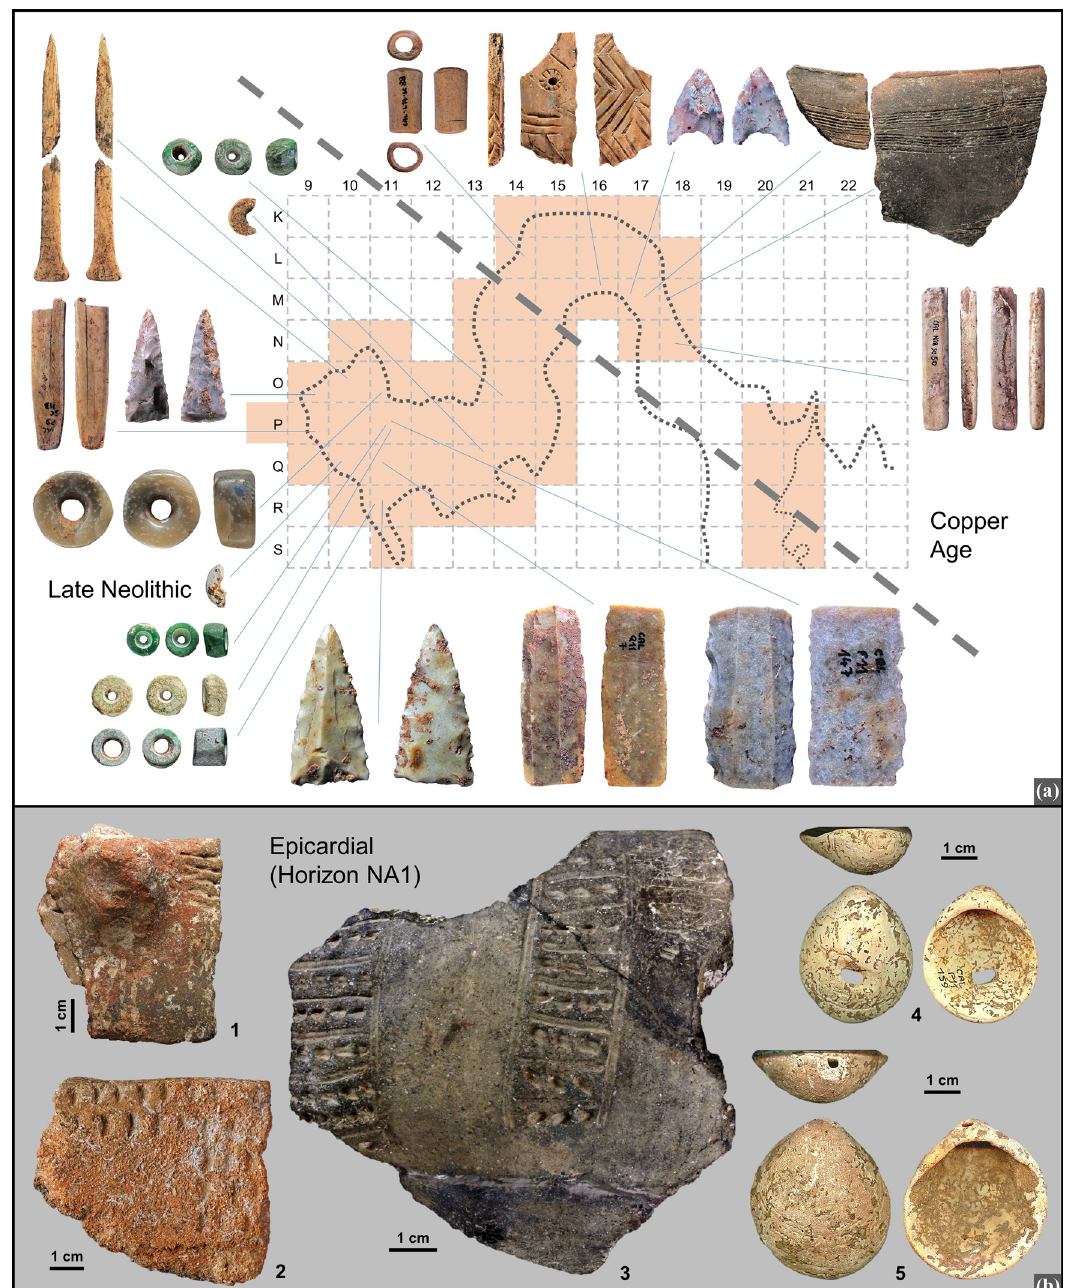
Figure 6: Gruta do Caldeirão. The post - Cardial Neolithic contexts. ( a ) Distribution of Late Neolithic and Copper Age diagnostics ( not to scale ) ; note the preservation of spatial structure despite the signi fi cant post - depositional disturbance ( Late Neolithic fi nds in the Back Chamber, Copper Age ones between Corridor and Entrance ) . ( b ) Impressed wares and body ornaments from the NA1 horizon. 1. Vessel 2; 2. Vessel 5; 3. Vessel 3; 4 and 5. Perforated Glycymeris glycymeris